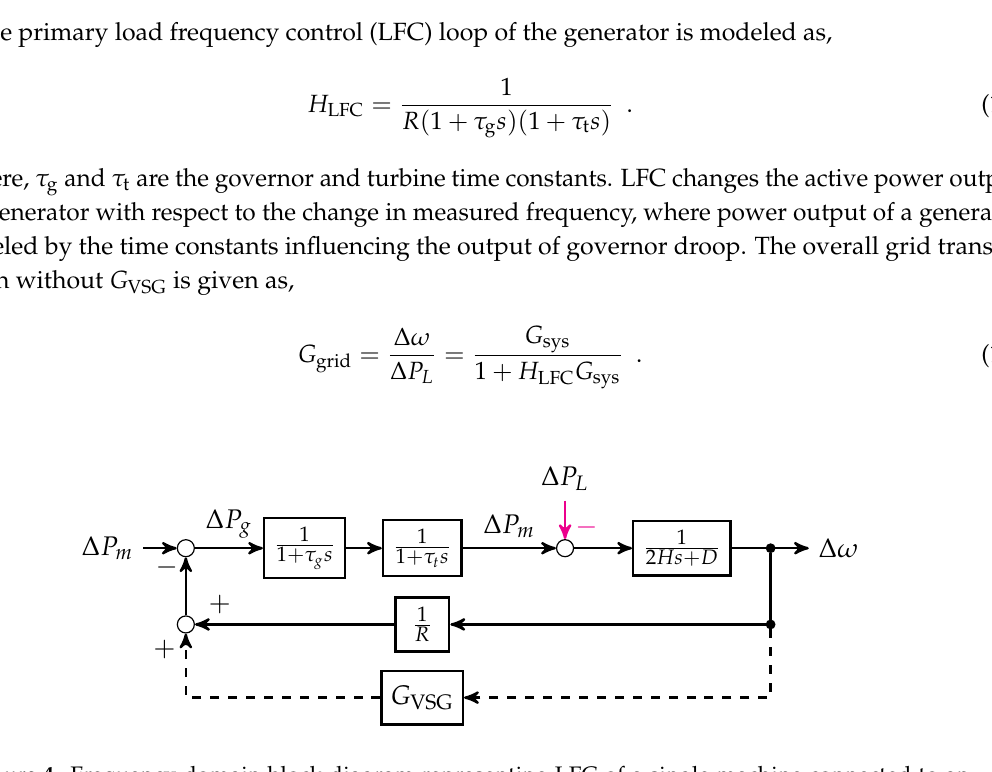
Figure 4. Frequency domain block diagram representing LFC of a single machine connected to an infinite